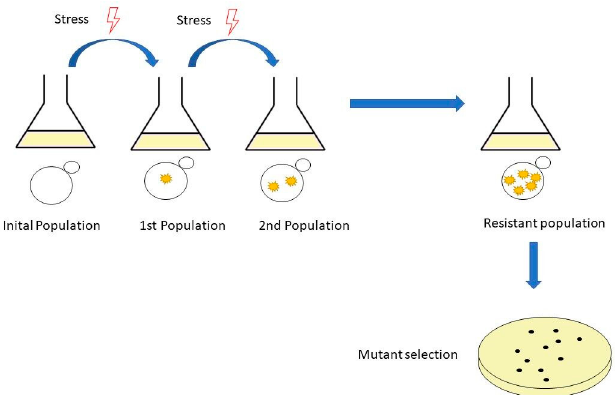
Figure 1. The workflow of adaptive laboratory evolution (ALE). It is performed by serial passages in shake flasks. The experiment starts with an initial population, followed by a population with mutations and, finally, a resistant population and mutant selection.